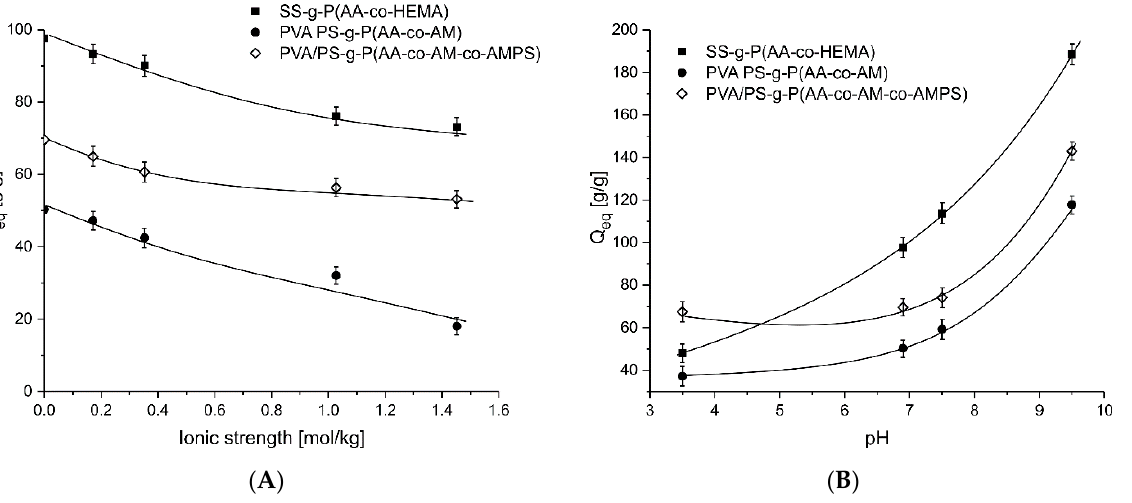
Figure 8. Dependence of hydrogels swelling on ionic strength ( A ) and pH ( B ).